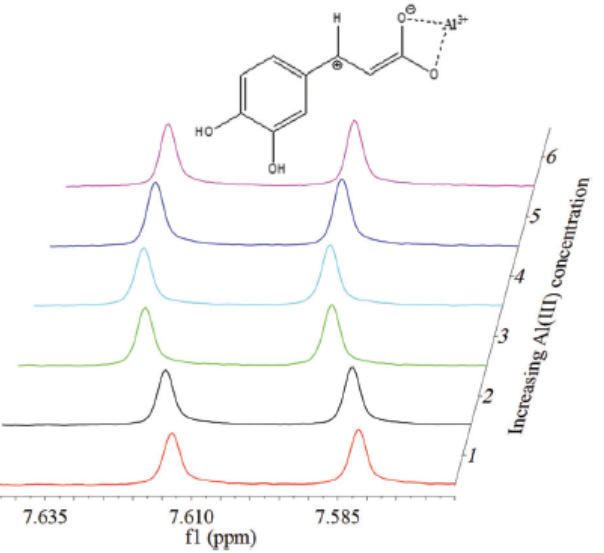
Figure 2. 1 H ‐ NMR doublet of the b proton of caffeic acid at pH = 3.5 and the deshielding effect caused by the formation of the complex with Al(III). Reproduced from [14] with permission from the Centre National de la Recherche Scientifique (CNRS) and the Royal Society of Chemistry.